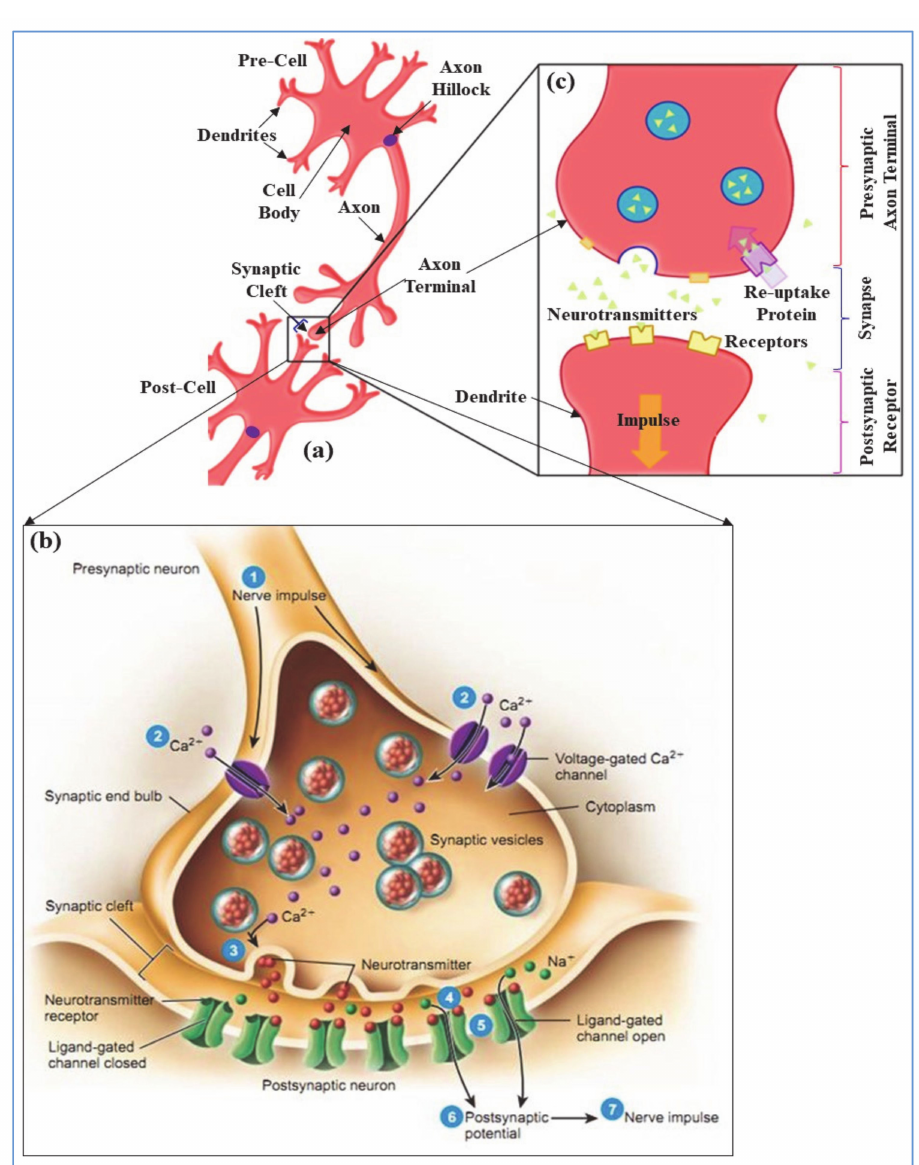
Figure 1. ( a ) Diagram of neuron–neuron communication in a neuronal network, ( b ) steps of bio-synaptic transmission, and ( c ) neurotransmitters reuptake